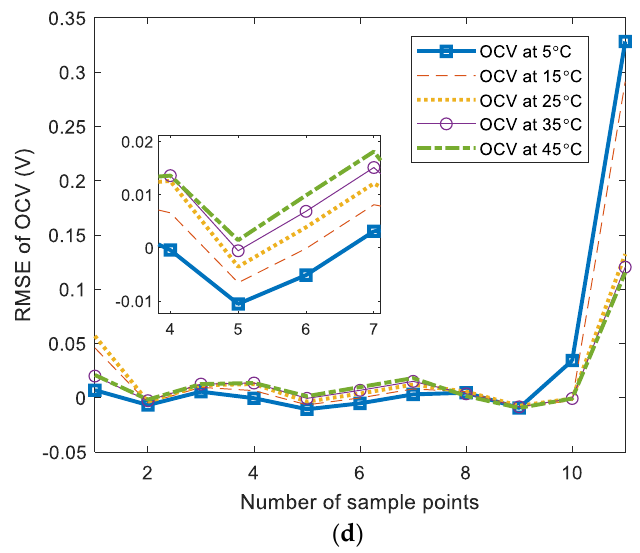
Figure 7. ( a ) proposed OCV-SOC relationship as compared to experimental data (at ambient temperature of 25 °C); ( b ) block diagram for OCV-SOC relationship at different ambient temperature ( c ) proposed OCV-SOC relationship to experimental data at different ambient temperature; ( d ) RMSE of OCV as compared to the proposed method at a different ambient temperature.